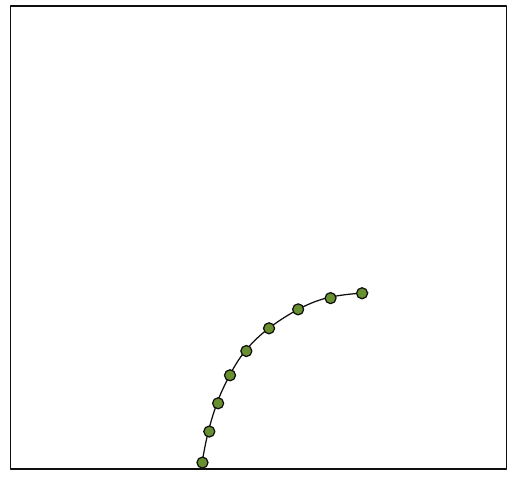
Figure 6: Initial geometry of the filament showing Lagrangian